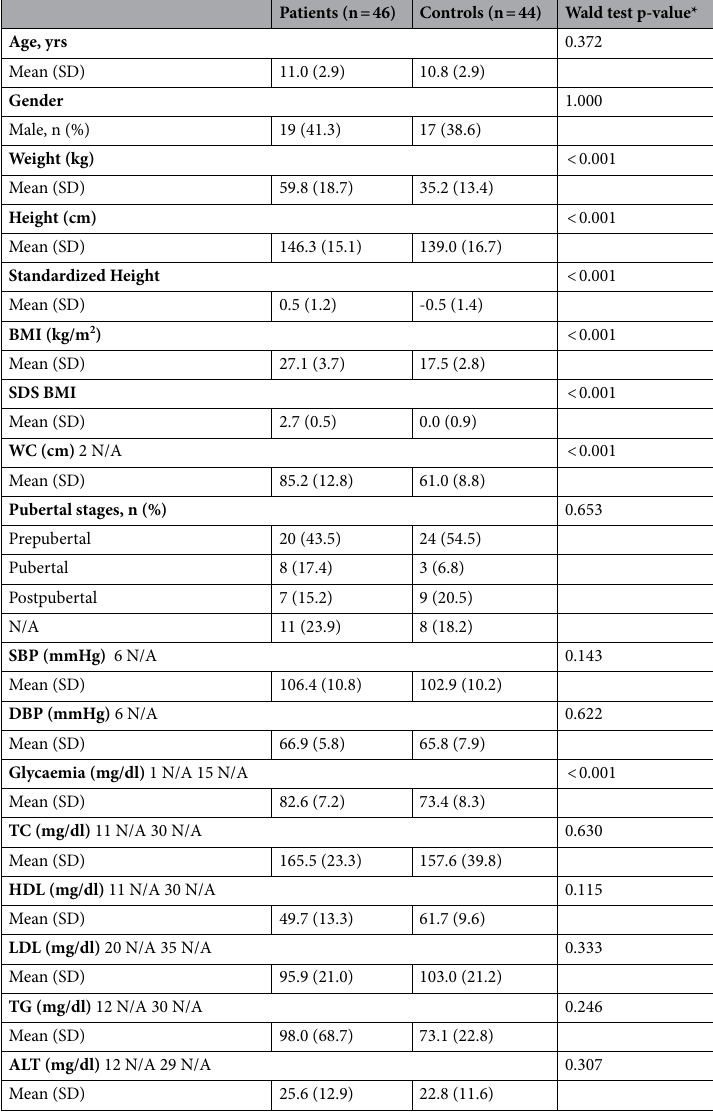
Table 1. Patients’ characteristics. BMI body mass index, DBP systolic blood pressure, HDL high density lipoprotein, LDL low-density lipoprotein, N Number, N/A Not available, SBP systolic blood pressure, TC